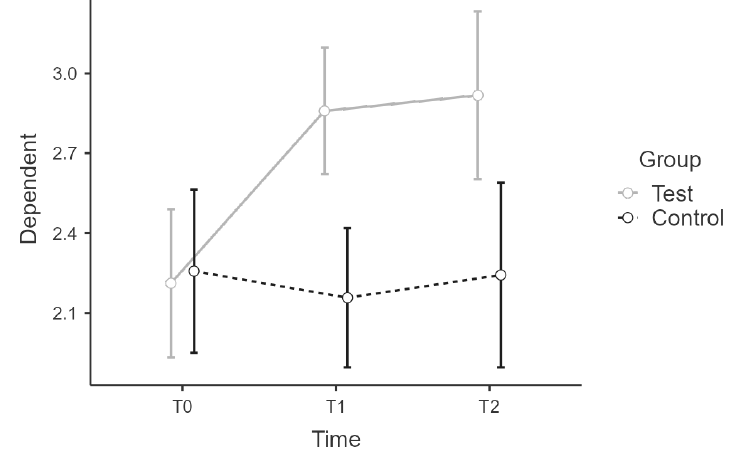
Figure 5. Estimated marginal means for PSQ TEN score.